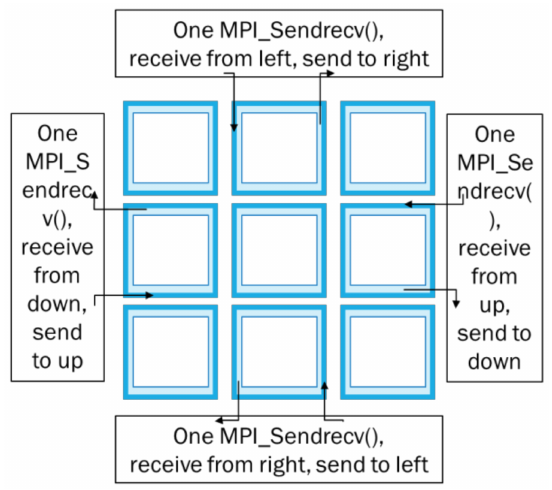
Figure 4. Schematic of data exchange.